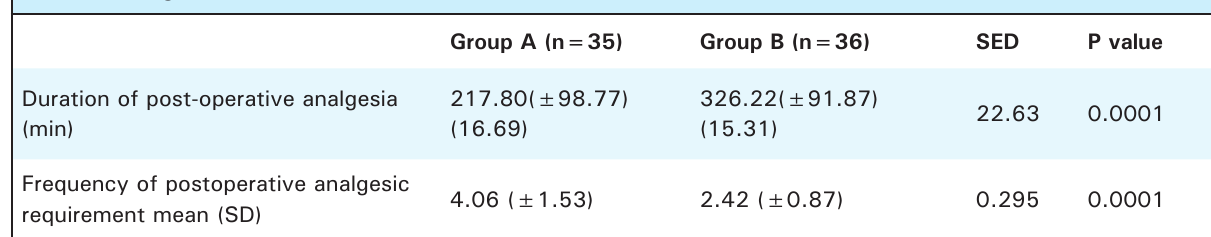
Table 1. Analgesia